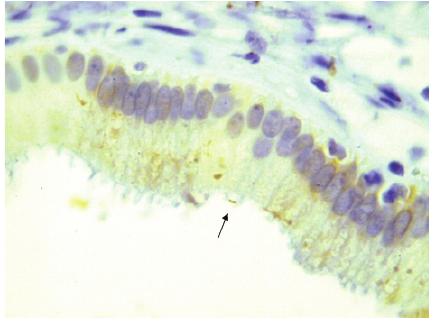
Figure1: H.pylori withinthegallbladdermucosaepithelium(MGG, × 1000).